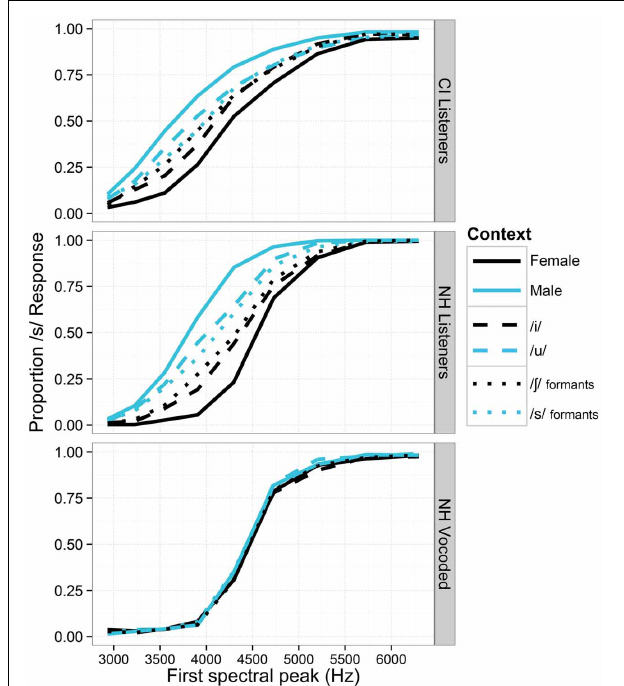
FIGURE 1 | Proportion of fricatives perceived as /s/ along the continuum of fricative spectra for all listener groups in Experiment 1. For each cue level, responses are collapsed across all levels of the other context types (i.e., for the gender contrasts, data are collapsed across both /i/ and /u/ vowel contexts, and both levels of the formant transition cue). Black lines depict cue levels expected to produce fewer /s/ responses. Sensitivity to context is demonstrated by the space between same-shaped lines of different colors.